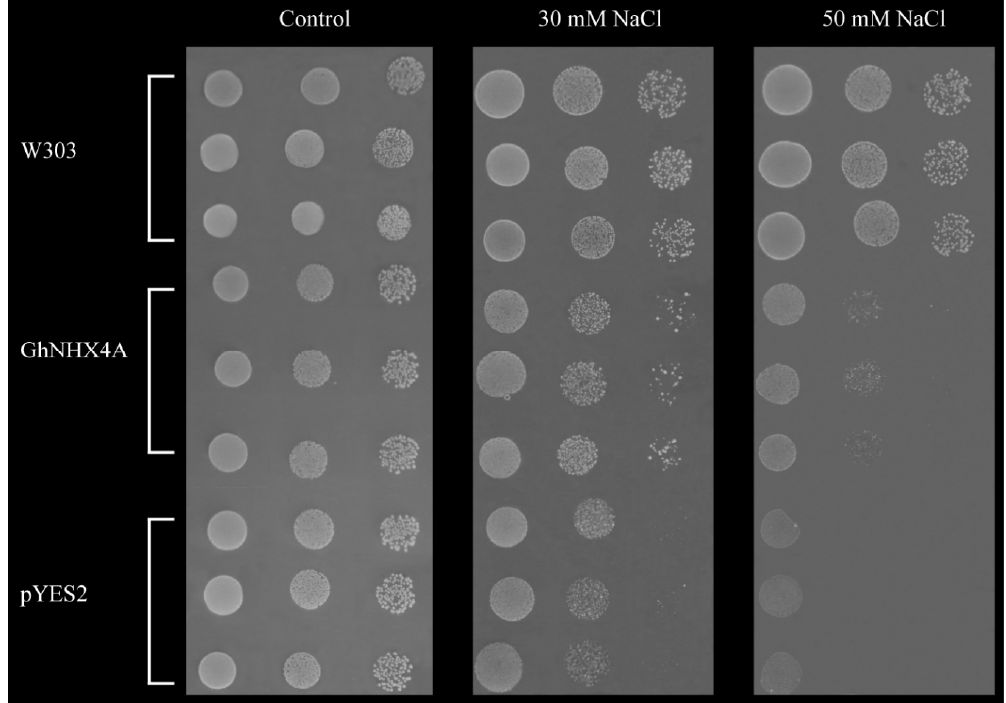
Figure 5. Functional complementation of GhNHX4A in yeast mutants. W303: Wild-type strain W303; GhNHX4A: Mutant strain AXT3 transformed with pYES2- GhNHX4A ; pYES2: Mutant strain AXT3 transformed with empty pYES2.